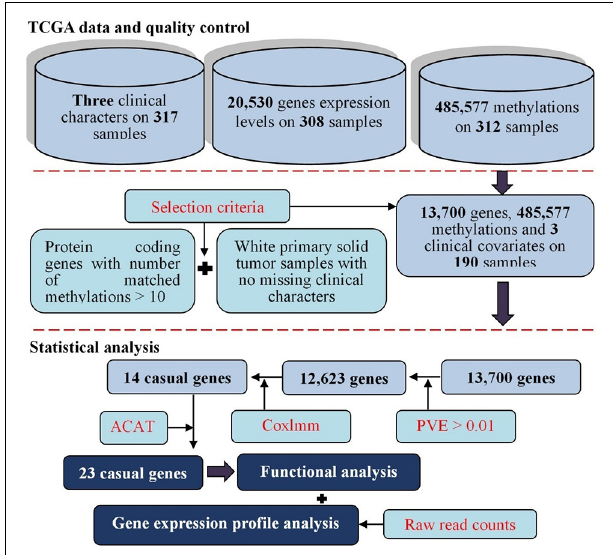
FIGURE 3 | Flowchart for the present study with datasets of cervical cancer available from TCGA. First, various levels of raw datasets were included for cervical cancer; we conducted a series of quality control for those raw datasets. Second, gene expressions predicted with methylations were generated with diverse prediction models, the Cox linear mixed-effects model was applied to identify methylation-driven genes based on predicted expression levels; we aggregated the p -values of genes from different prediction models through a p -values combination manner to find significant genes that were related to the survival of cervical cancer. Finally, we further implemented functional and differential expression analyses for newly identified associated